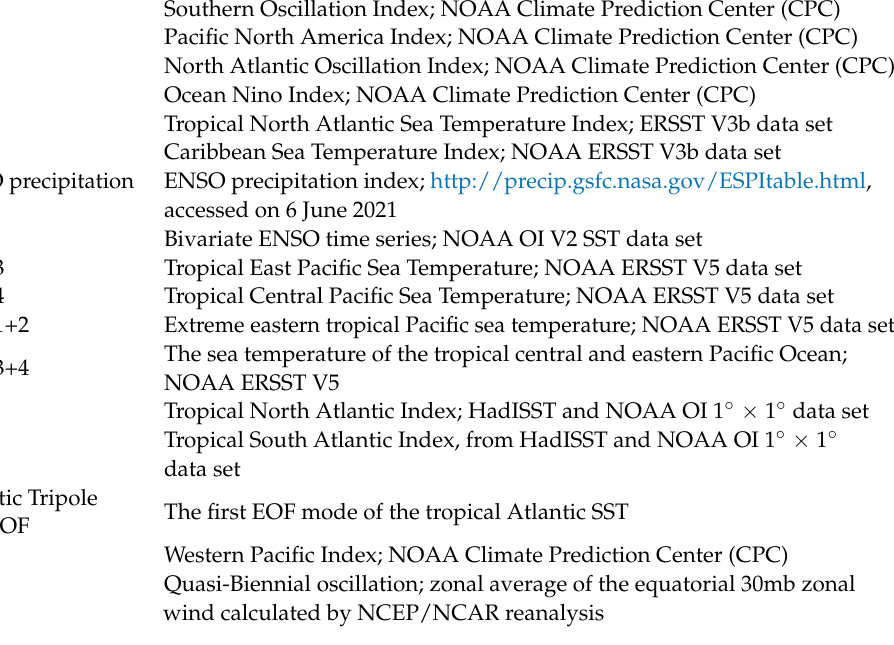
periods. Figure S6: As Figure S5, but for GABP precipitations. Figure S7: As Figure S5, but for SVM precipitations. Figure S8: As Figure S5, but for MLR precipitations. Table S1: The GABP basin-averaged MAPE values in the training